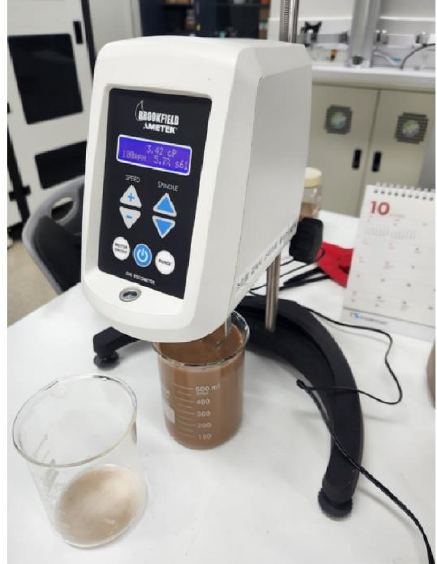
Figure 9. DVE viscometer.